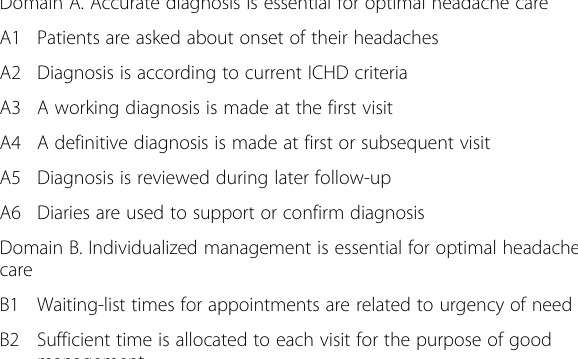
Table 4 Domains and indicators of quality in headache service delivery (from